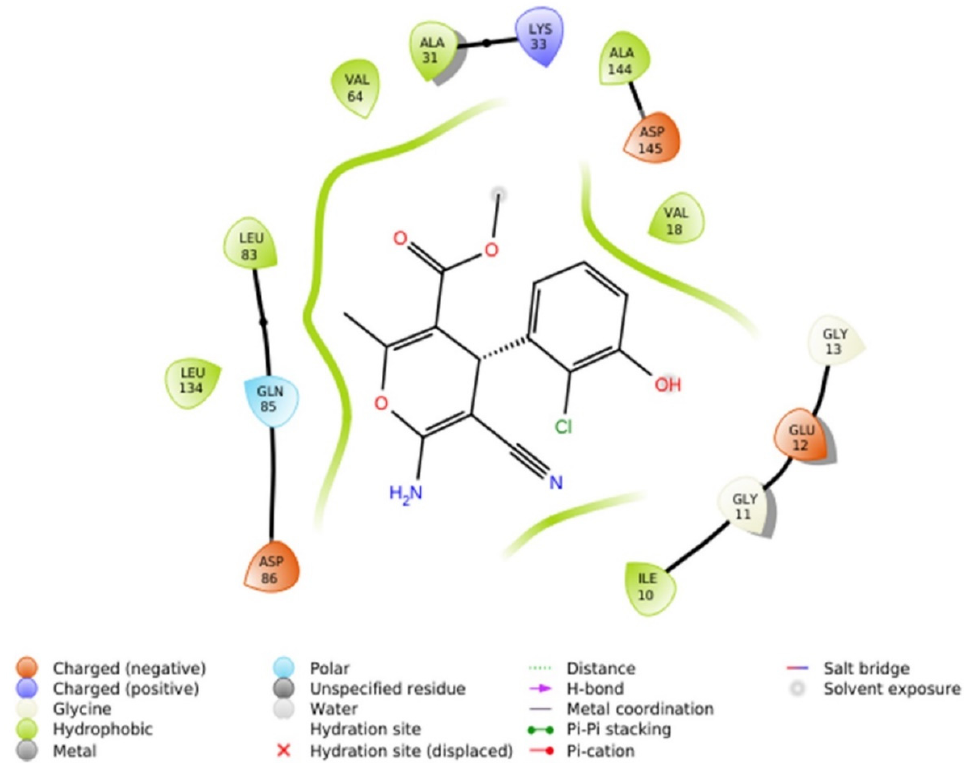
Figure 14. Two-dimensional model of binding interactions of compound 4f after docking calculations in the ATP binding pocket of CDK2. Moreover, the docking analyses of 4d , 4k and 4f successfully provided information on possible structural modifications to improve kinase inhibitory efficiency. These anal- yses highlighted that an inhibitor for CDK2 requires a bulkier ring to be attached to the main scaffold (the pyran ring in the present case) through a flexible chain of two to three atoms. Furthermore, it should be present at the periphery of the molecule to penetrate well inside the ATP binding site to establish lipophilic and mild polar interactions [69]. In addition, docking analyses indicated that H-bond donors or acceptors on the central scaf- fold could substantially enhance binding with the receptor. 2.2.4.2. In Vitro CDK2 Inhibitory Assays To further substantiate the promising results of the docking analyses of pyrans 4d and 4K in the ATP active site of CDK2, their in vitro potencies to inhibit the enzym ac- tivity were evaluated over a concentration range of 0.01 − 10 µM. The results of kinase as- says (Figure 15) revealed that both pyrans strongly affected CDK2 activity in a dose-de- pendent manner. Thus, compound 4d , at 0.01, 0.1, 1, or 10 µM, decreased CDK2 activity by 26.9, 41.5, 72.5 and 89%, respectively, while compound 4k inhibited kinase efficiency by 21.9, 42.4, 66.3 and 83.6%, respectively, at the same concentrations. On the other hand, the positive control BMS-265246 was found to be more effective and reduced CDK2 ac- tivity by 92.3% at the highest concentration used (10 µM).